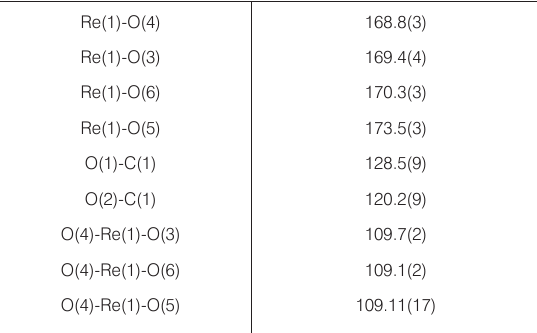
Fig. 3 shows the asymmetric unit cell labels and the 50% vibration ellipsoids.